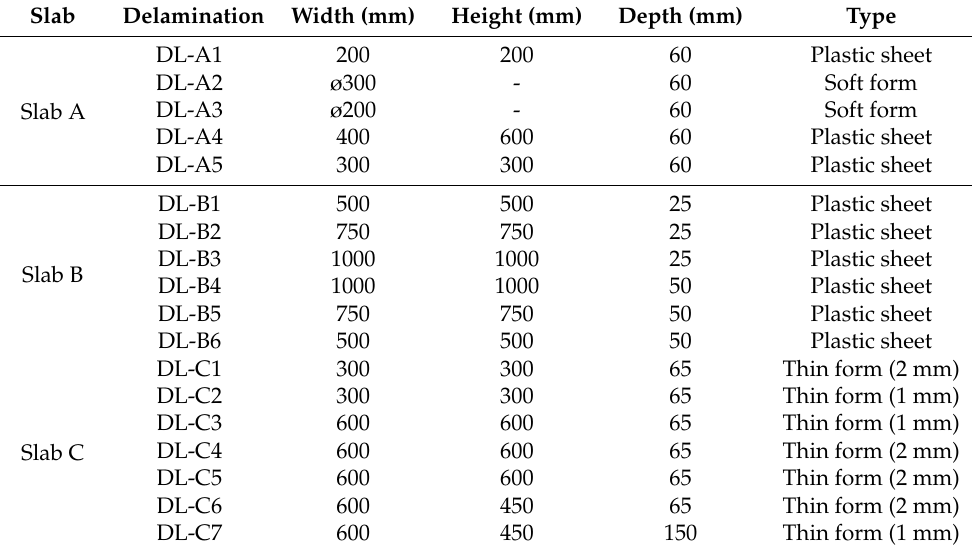
Table 1. Attributes of specimens depicting artificial defects used for the training and validation of SL and SSL